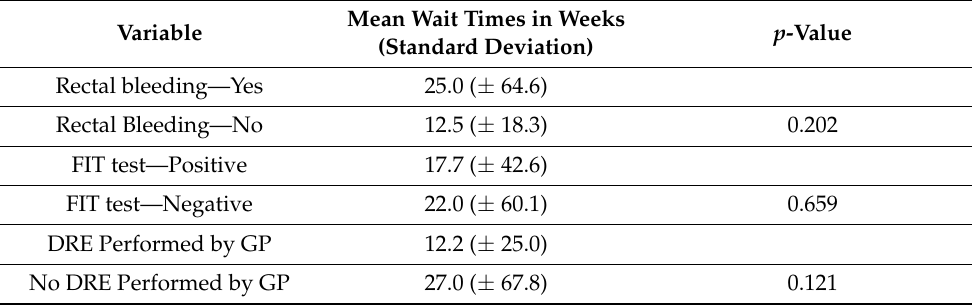
Table 3. Self-reported time between being seen by GP and specialist (gastroenterologist, surgeon, or